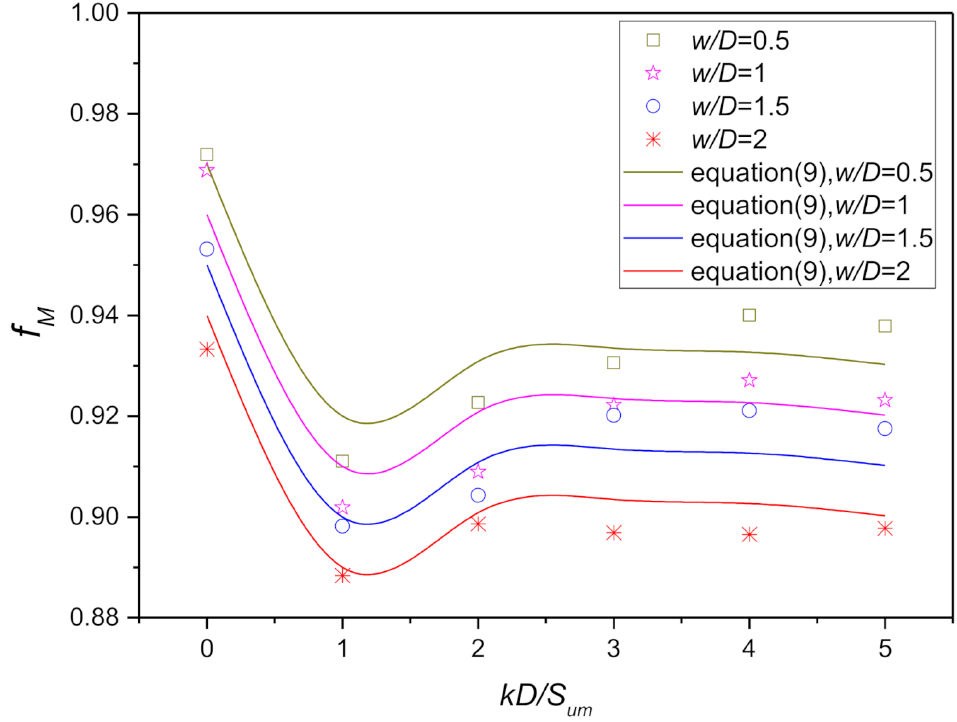
Figure 25. Reduction factors of moment dimensionless elastic stiffness coefficients related to kD and w . D